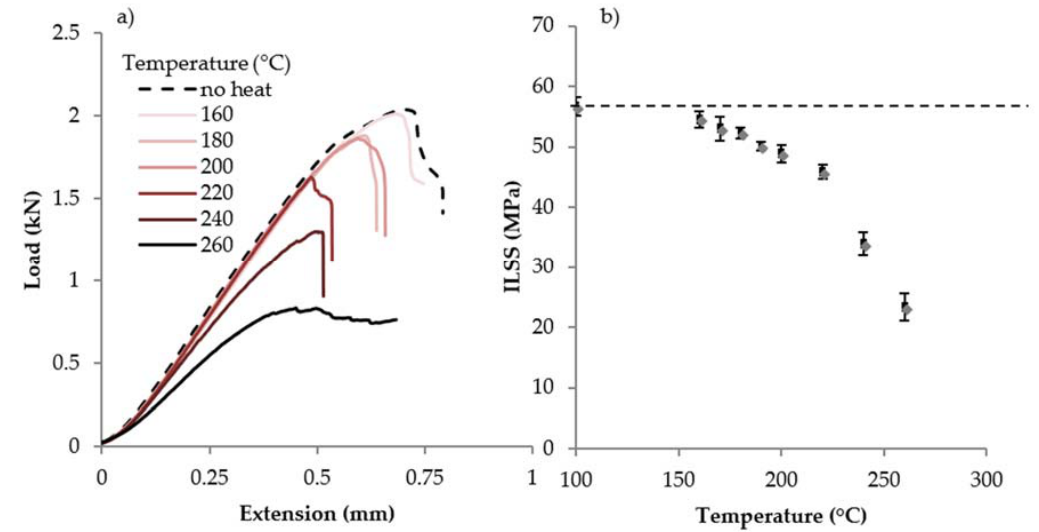
Figure 5. ( a ) Load vs. extension curves for short-beam samples of CFRE panel exposed to 1 h at various temperatures; ( b ) ILSS of samples exposed for 1 h. The dashed line in ( b ) represents the ILSS measured for samples with no thermal exposure.